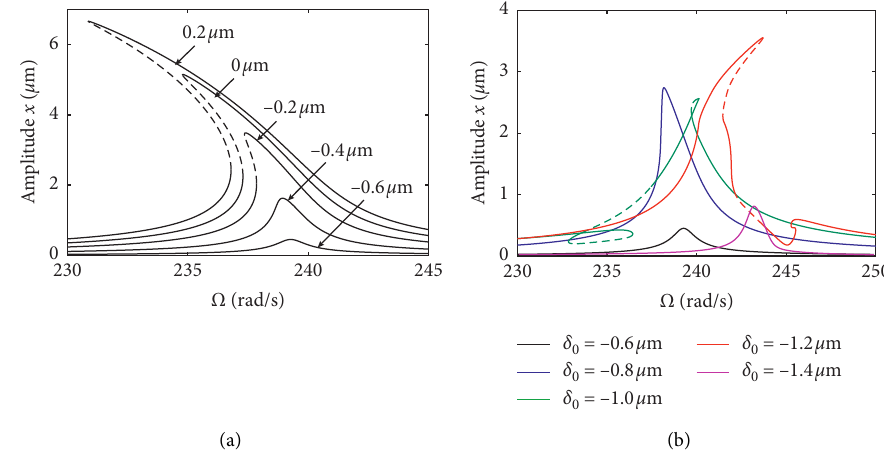
Figure 11: Influence of bearing clearance δ 0 on period-1 frequency-response peak-to-peak curves in the x -direction for c solid and dashed lines refer to stable and unstable responses,